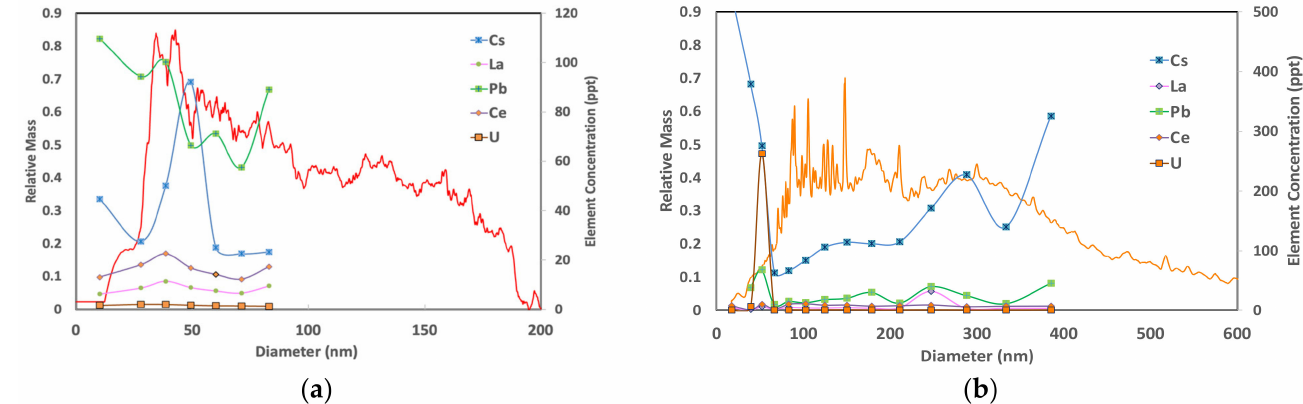
Figure 9. Size-dependent elemental distribution of trace elements Cs, La, Pb, Ce, and U in nanopar- ticles isolated from the miner sample. The red ( a ) and orange ( b ) lines show the size distribution, measured by AsFlFFF ( a ) and SdFFF ( b